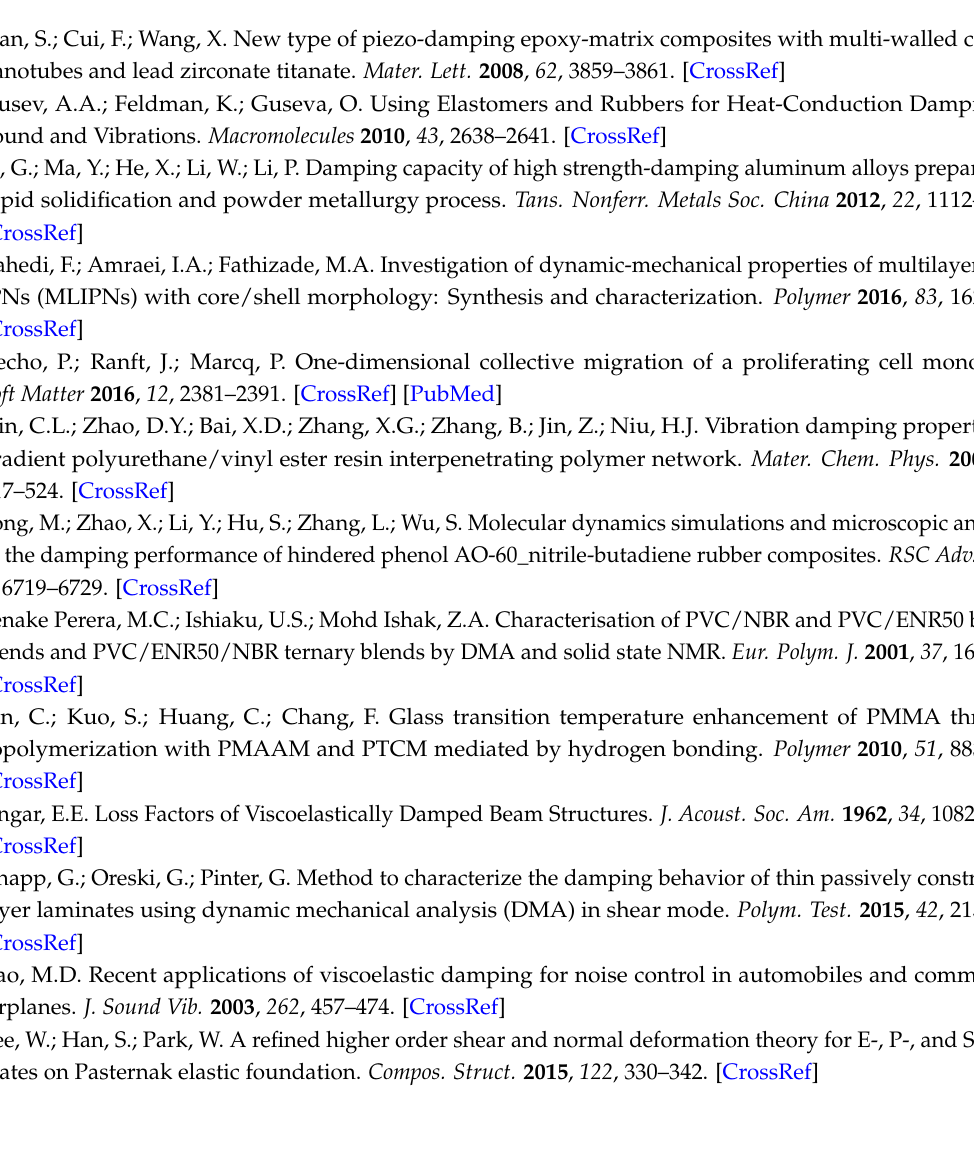
Figure S5: ATR-FTIR results of the chosen regions of the gradient sample. Devices applied here have been revised before detection and all curves here have subtracted the baseline, Figure S6: FTIR spectra of the locations chosen from the homogeneous IPN, Table S1: Element distribution of the selected slices from the